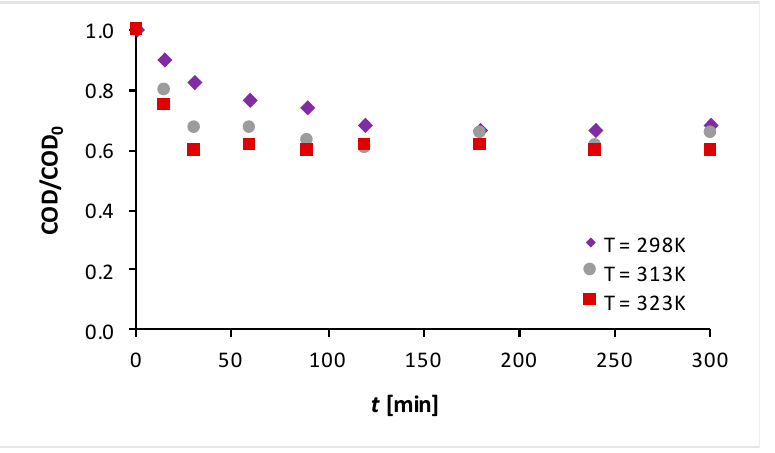
Figure 1. COD/COD 0 profile vs. reaction times for experiments conducted at different temperatures. The tests were conducted by fixing the following operation conditions: COD 0 = 200 mg/L, ρ B = 0.5 g/L, Q air = 1.0 × 10 − 6 m 3 /s, and v = 500 rpm.